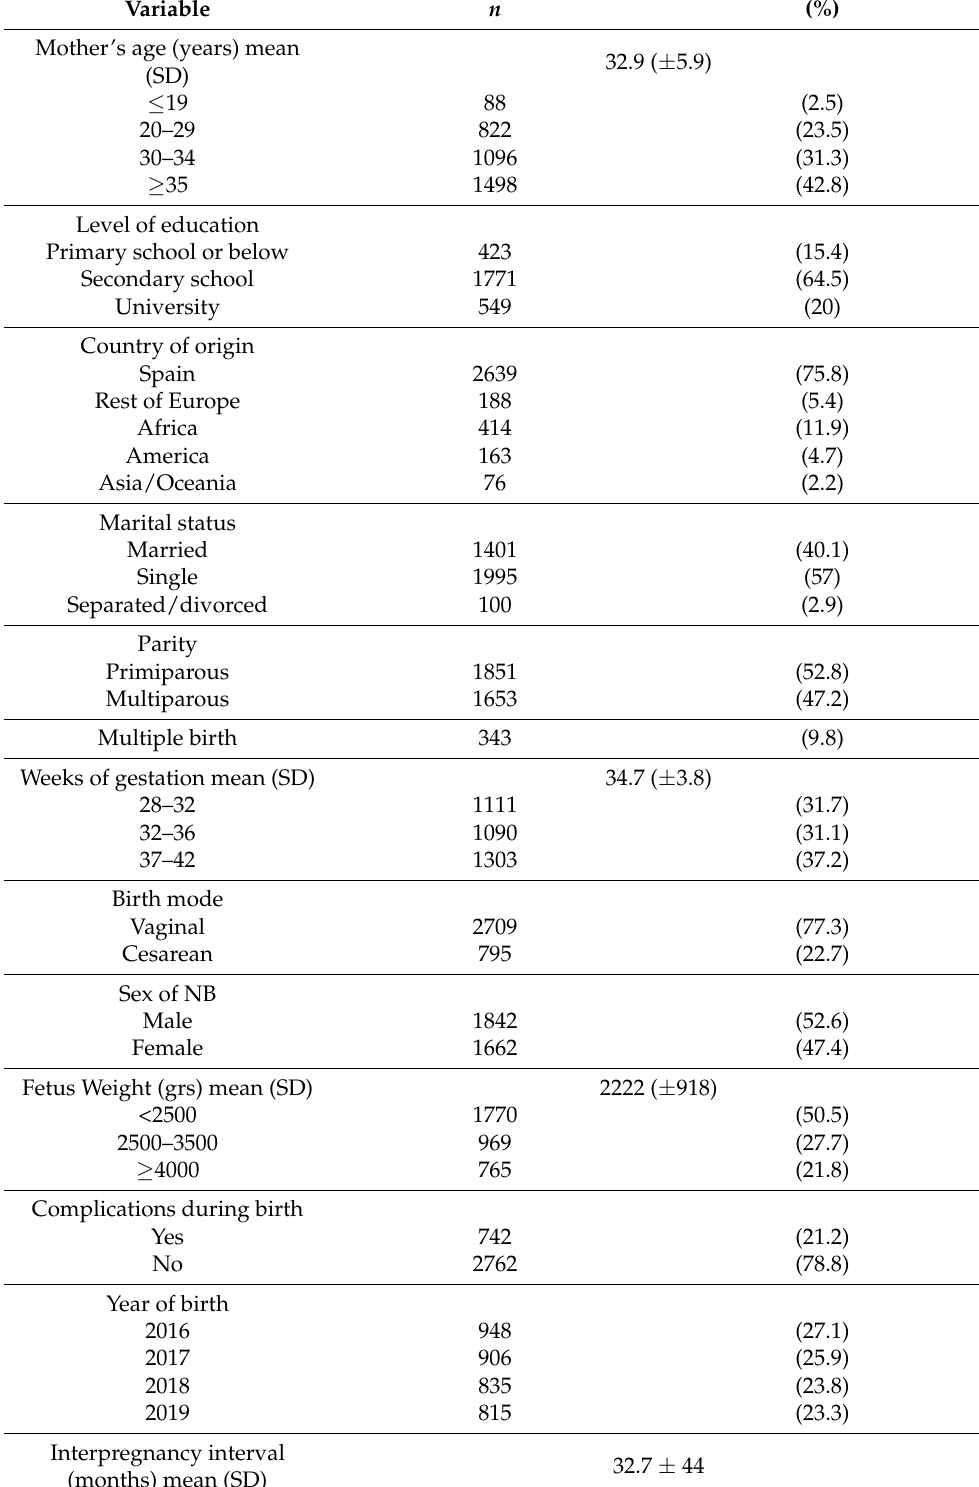
Table 1. Sociodemographic, obstetric and fetal characteristics in the national cohort studied, 2016–2019 ( n =